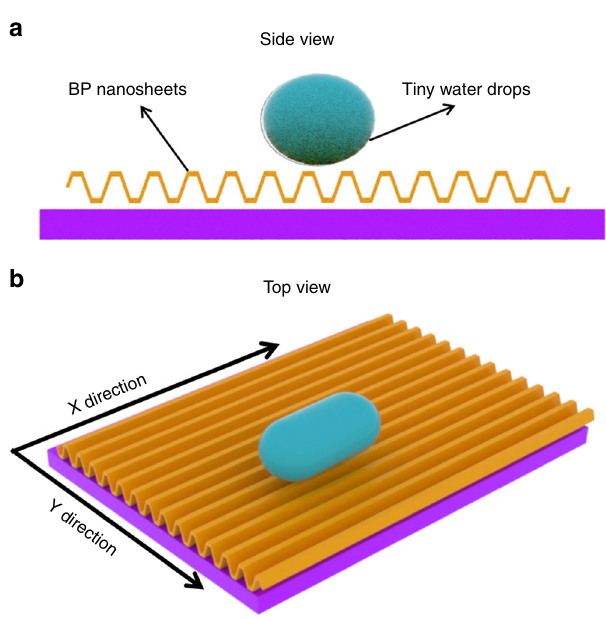
Fig. 3 The schematic diagram of water droplet on the surface of BP. a Side view and b top view. The X direction is in the zigzag structure and the Y